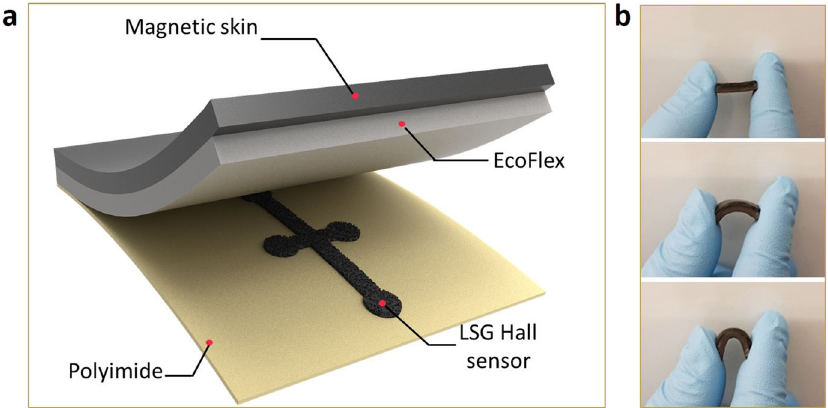
Fig. 6 A soft tactile sensor. a Assembly of a fl exible LSG tactile sensor. b Optical photograph of the tactile sensor demonstrating its fl exibility. sensor into a single architecture of 10 × 10-mm shape, as shown in Fig. 6. Applying a normal force to the top of the platform changes the distance between the fl exible magnet and the LSG Hall sensor through the deformation of the elastomer, causing a magnetic- fi eld variation at the sensor location. Three layers of the platform